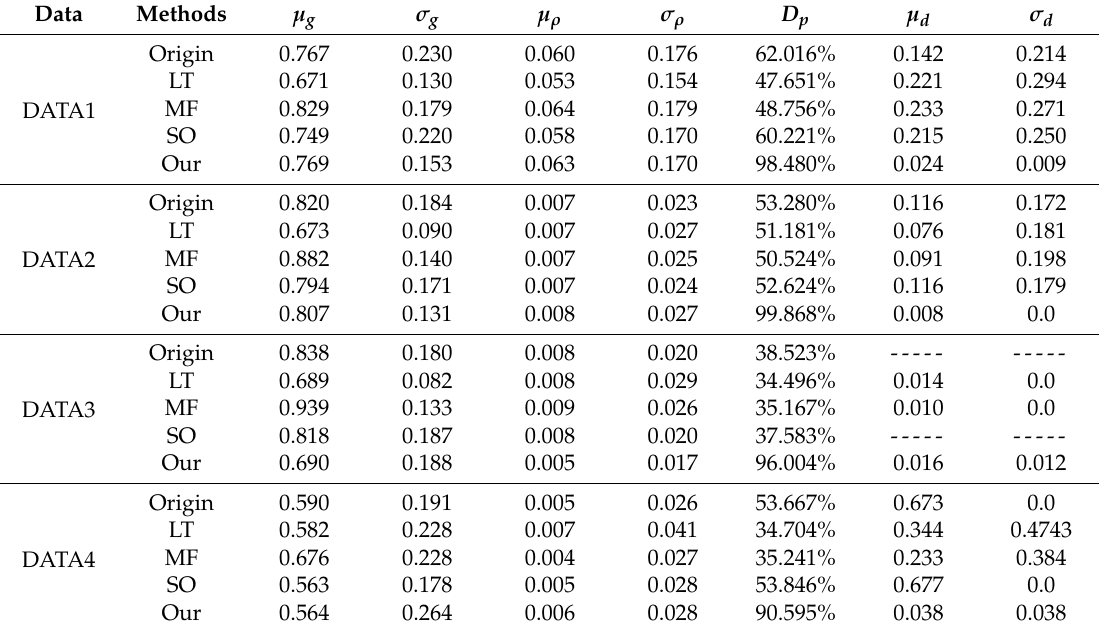
Table 2. Stripe quality evaluation under different processing methods.